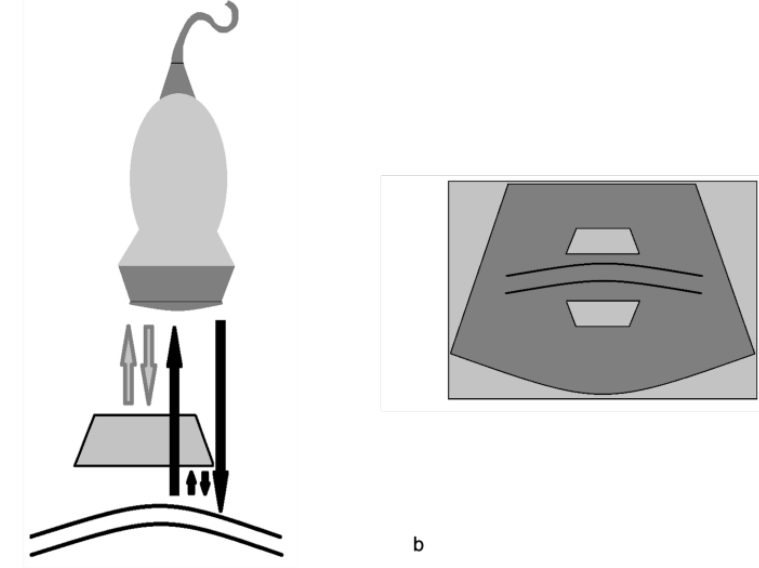
Figure 3. Mirror-image artifact. ( a ) In this diagram, the gray arrows represent the expected reflective path of the US beam. These echoes are displayed properly. The black arrows show an alternative path of the primary ultrasound beam. It encounters another structure (e.g., a nodular lesion) in its path and is reflected back to the highly reflective surface (e.g., diaphragm). It then reflects back towards the transducer again. ( b ) The echoes from the deeper reflective interface take longer to return to the transducer and are misplaced on the display. Modified from Feldman MK et al. [5].